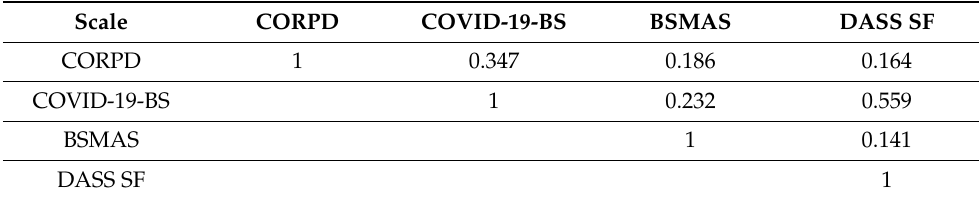
Table 4. Correlation values between scales. Scale